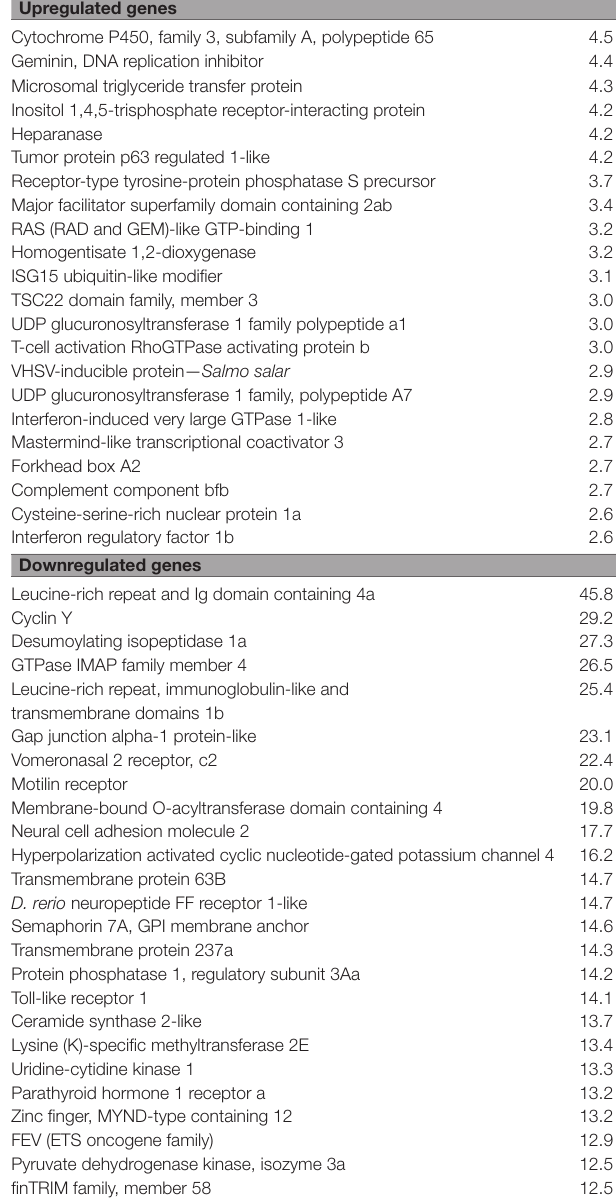
TaBle 1 | Top 25 most up- and downregulated genes in β -glucan-treated zebrafish compared to unstimulated fish in the absence (A) or presence (B) of Spring Viremia Carp Virus (SVCV)